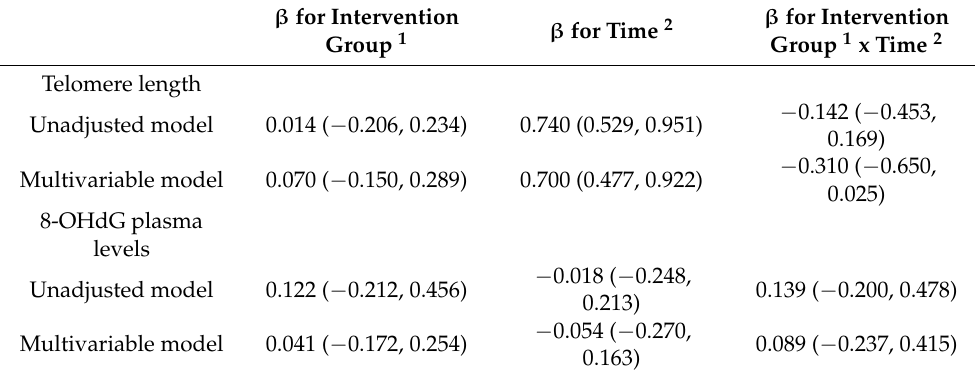
Table 4. One-year changes in telomere length and 8-OHdG plasma levels according to the interven- tion group, time, and its interaction (effect of the